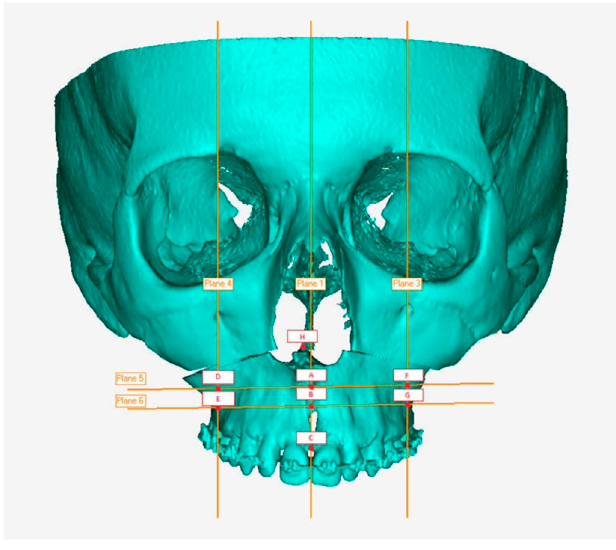
Figure 10. Eight-point